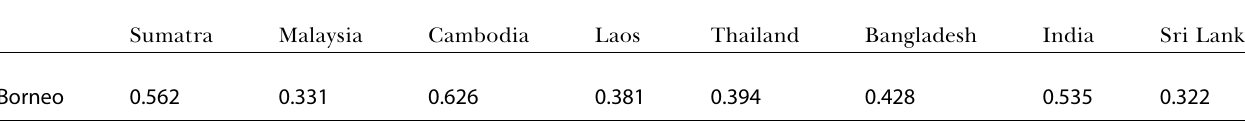
Table 3. F ST Values in Pairwise Comparison of Borneo with Other Populations Sumatra Malaysia Cambodia